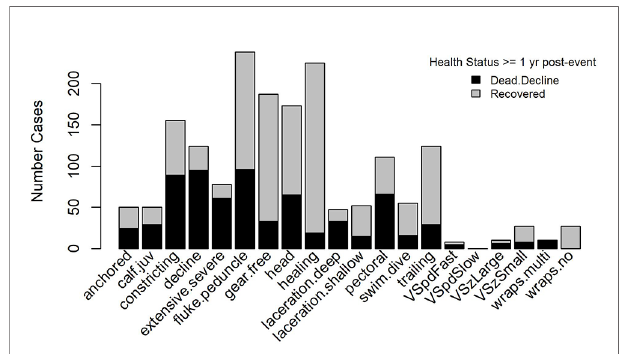
FIGURE 1 | Occurrence of variables from entanglement and vessel strike narratives, strati fi ed by known health status ≥ 1 year post-event. In most injury cases, vessel size and speed were unknown and effectively represented a variable with a constant value. Thus the number of ‘ VsSzUnk ’ and ‘ VsSpdUnk ’ values are not shown to prevent y-axis distortion that would mask patterns evident for known vessel sizes